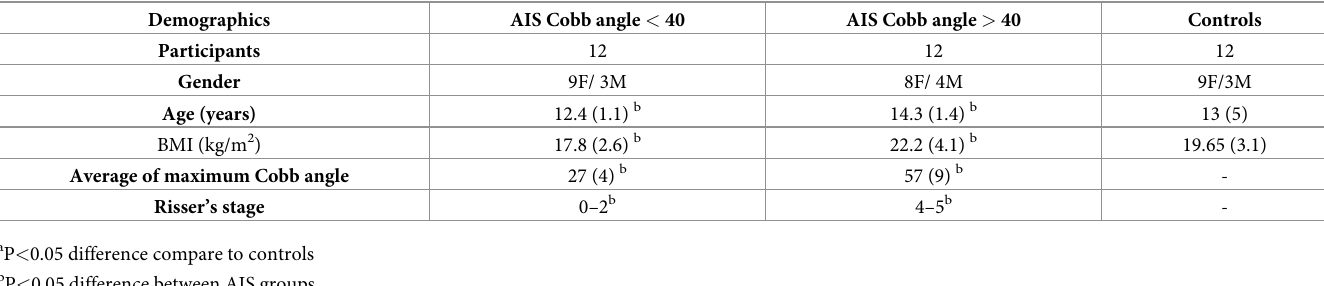
Table 1. Demographics of